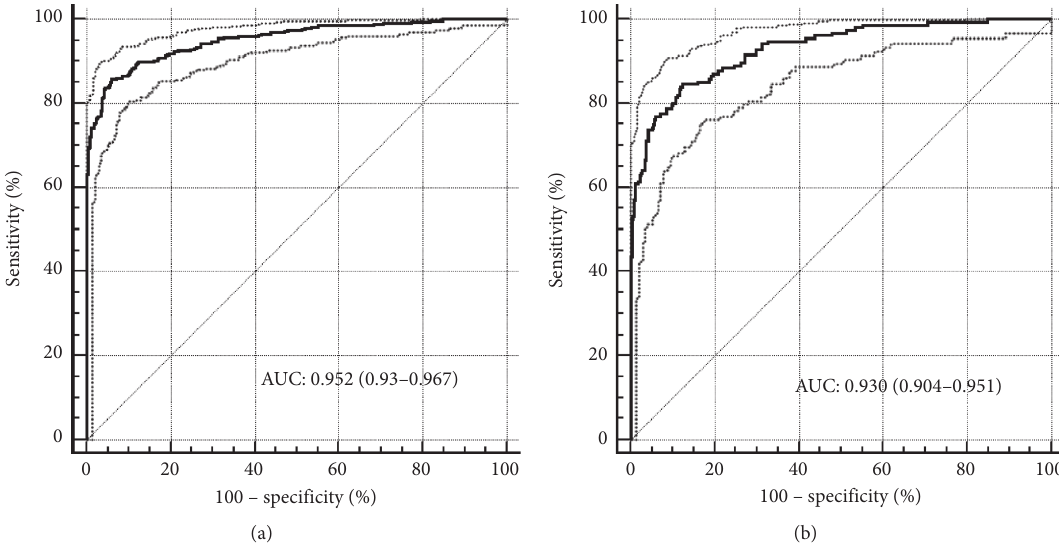
Figure 3: ROC analysis of SP-A1 for detecting keratoconus eyes and mild keratoconus eyes from normal eyes. (a) All keratoconus eyes. (b) Mild keratoconus